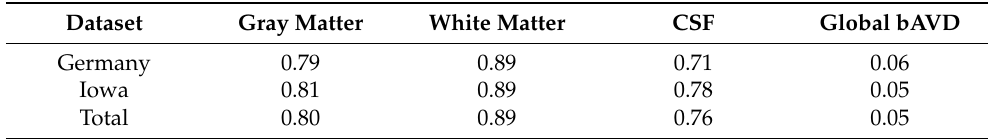
Table 6. Gray and white matter and cerebrospinal fluid segmentation similarity to Atropos. White matter was consistently the most similar between two models, with a DICE score of 0.89. The distance erros were consistant at 0.05 voxels across the test